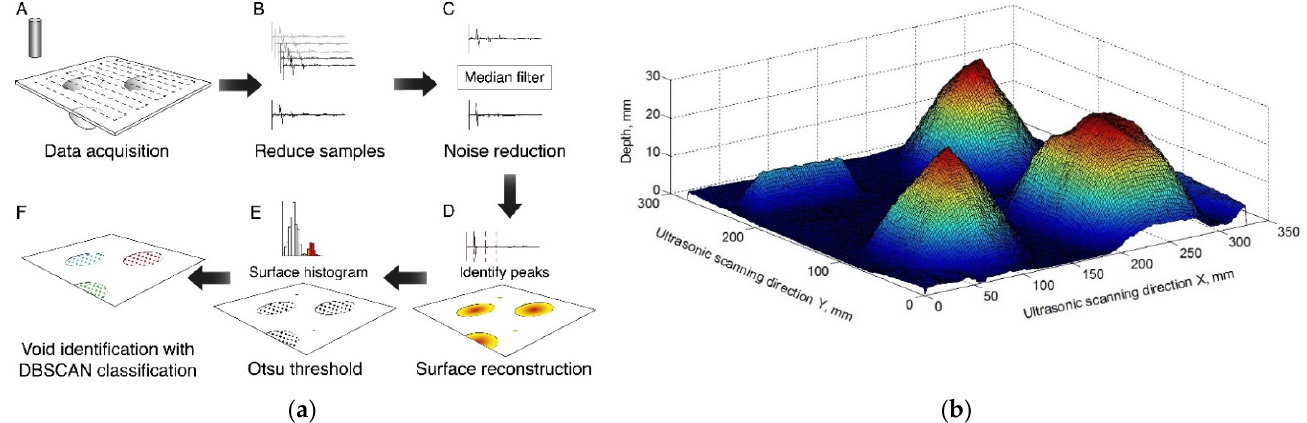
Figure 4. 3D reconstruction of void detection, ( a ): data analysis process; and ( b ): an example of 3D voids measured by 5 MHz transducer with replacement density sand.